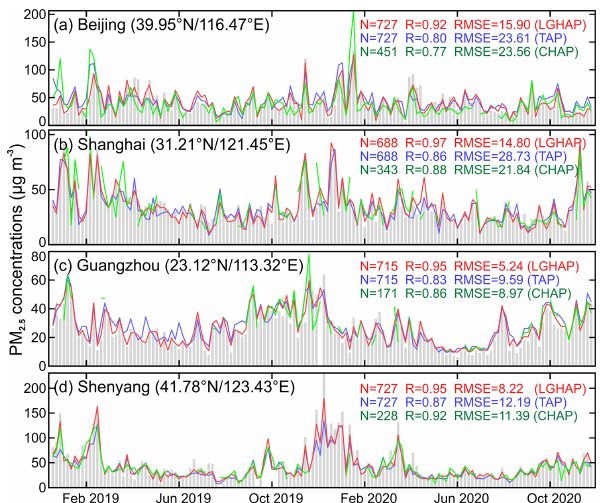
Figure 7. Comparison of PM 2 . 5 concentration time series be- tween LGHAP (red line) and two open datasets (blue: TAP; green: CHAP). Here, hourly PM 2 . 5 concentrations measured by four United States embassies in China from 2019 to 2020 (grey bar) were used as an independent PM 2 . 5 dataset to validate these three daily products. CHAP and TAP are two open-access datasets providing PM 2 . 5 concentration that were created by J. Wei et al. (2021) and Geng et al. (2021),